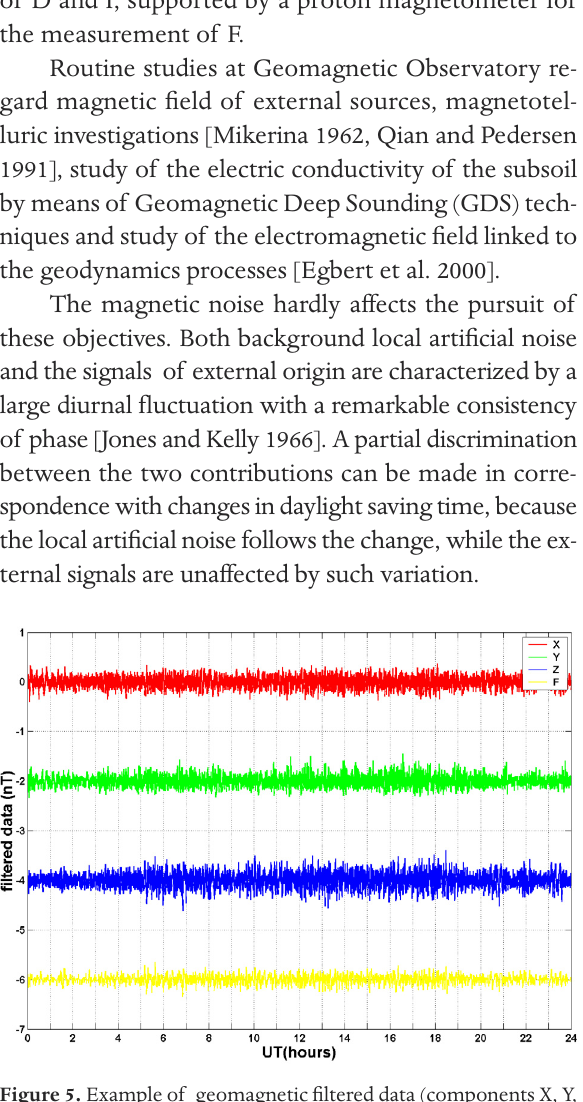
Figure 5. Example of geomagnetic filtered data (components X, Y, Z and total intensity field F) relative to a selected day with local K index approximately